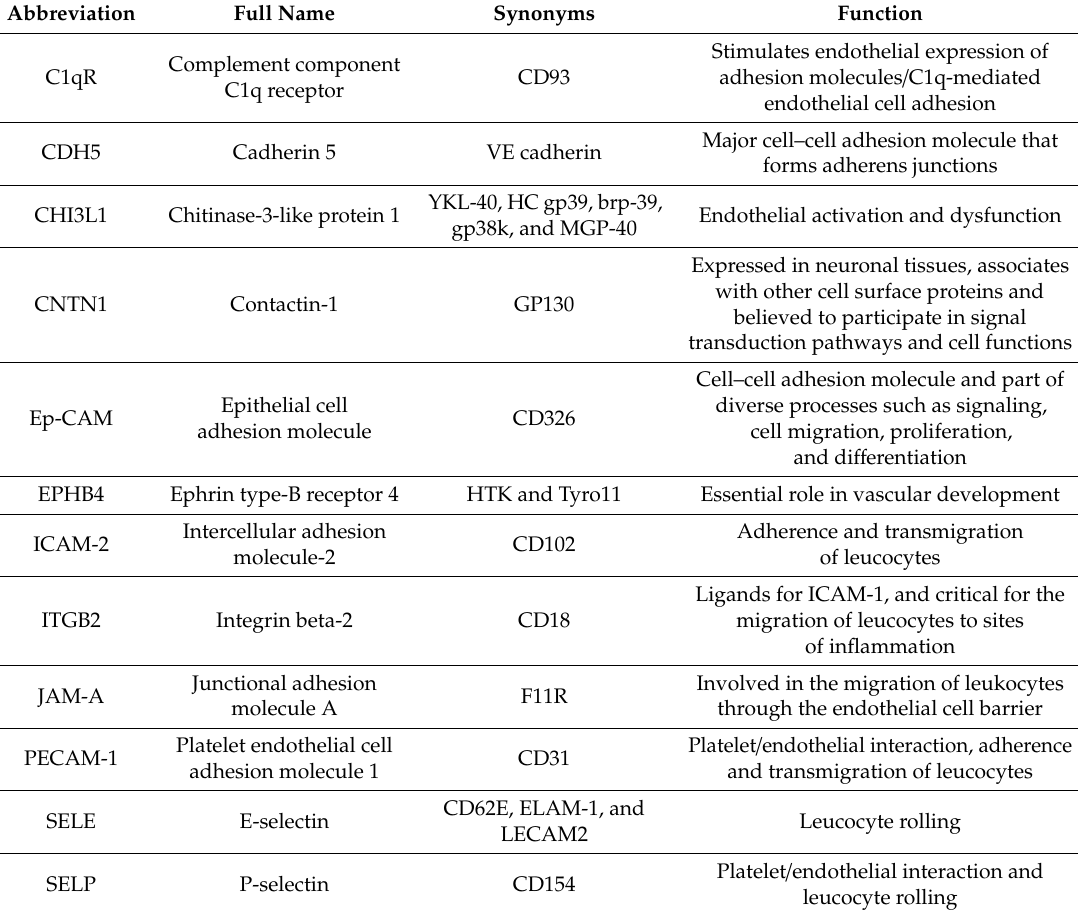
Table A1. Overview of the assessed biomarkers of cell